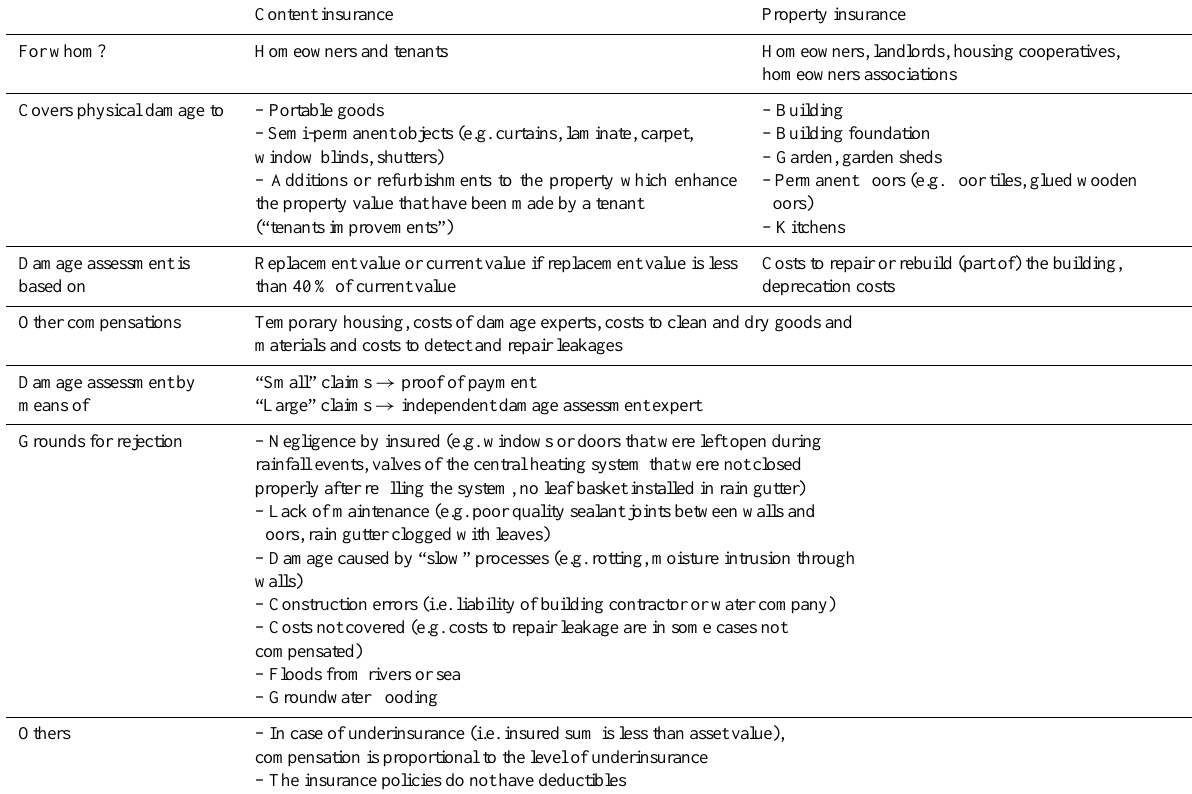
Table 2. Key features of the home insurance policy related to the damage database used in present study. Content